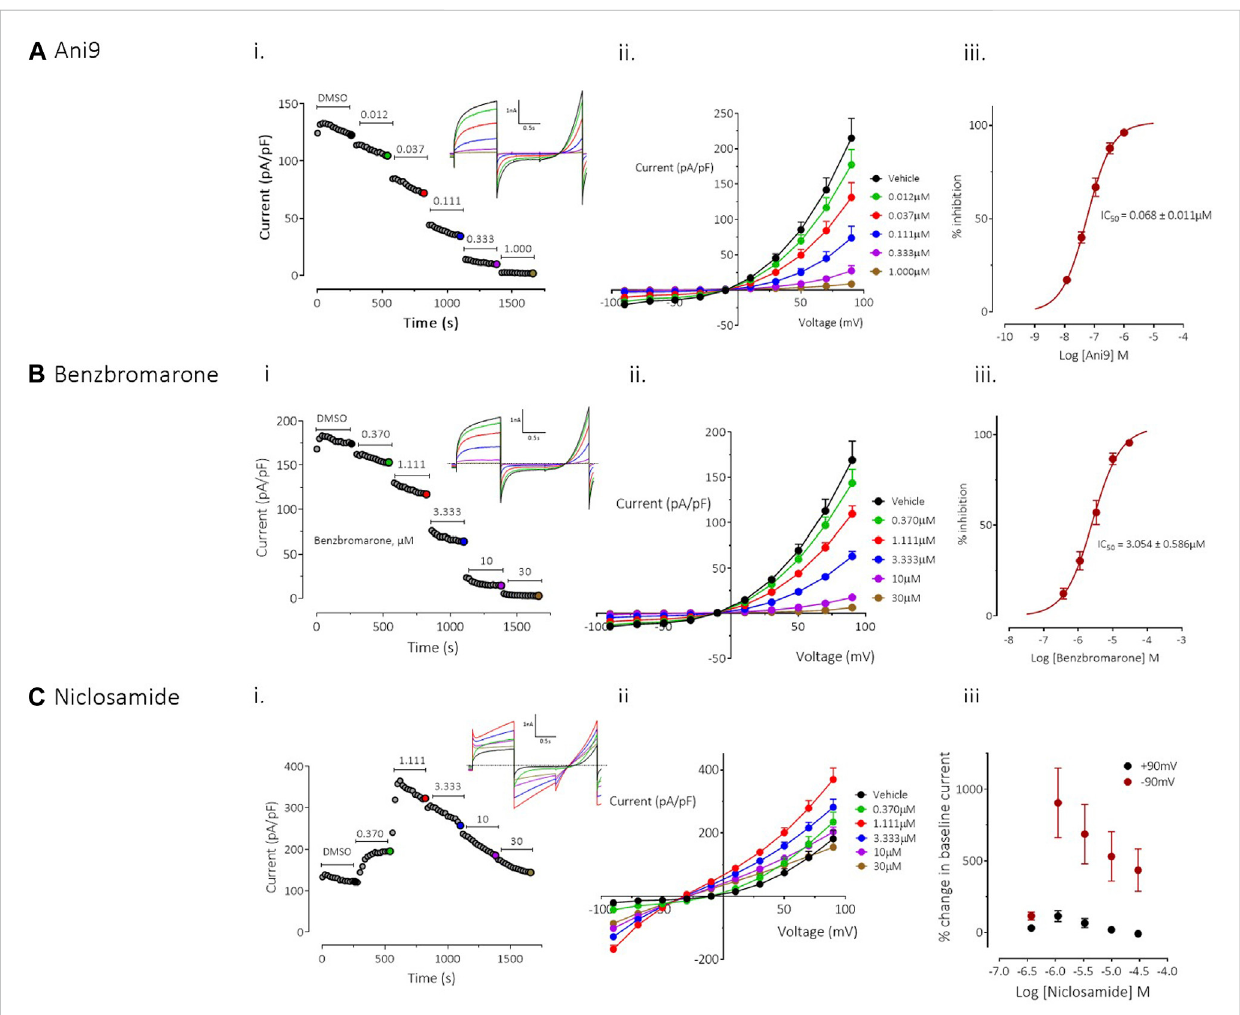
FIGURE 1 Effects of Ani9, benzbromarone and niclosamide on hTMEM16Aabc currents. Whole-cell patch clamp recordings of the effects of Ani9 (A) , benzbromarone (B) andniclosamide (C) onhTMEM16AabccurrentsmeasuredinFRTcellswith[Ca 2+ ] i clamped at415 nM.Samplecurrent-timecurves(i) for the effects of the indicated compound concentration on peak current at +90mV; inset shows raw current traces for the time points indicated by the coloureddots.Meancurrent-voltagerelationshipforeachconcentrationtested(ii)andconcentration-responsecurves(iii)arealsoshown. Symbols in(ii)and (iii)representthemeandata ±SEM. ( n = 4 – 10experimentsineach group).IC 50 = concentration oftestcompound required toinhibit50%ofthe